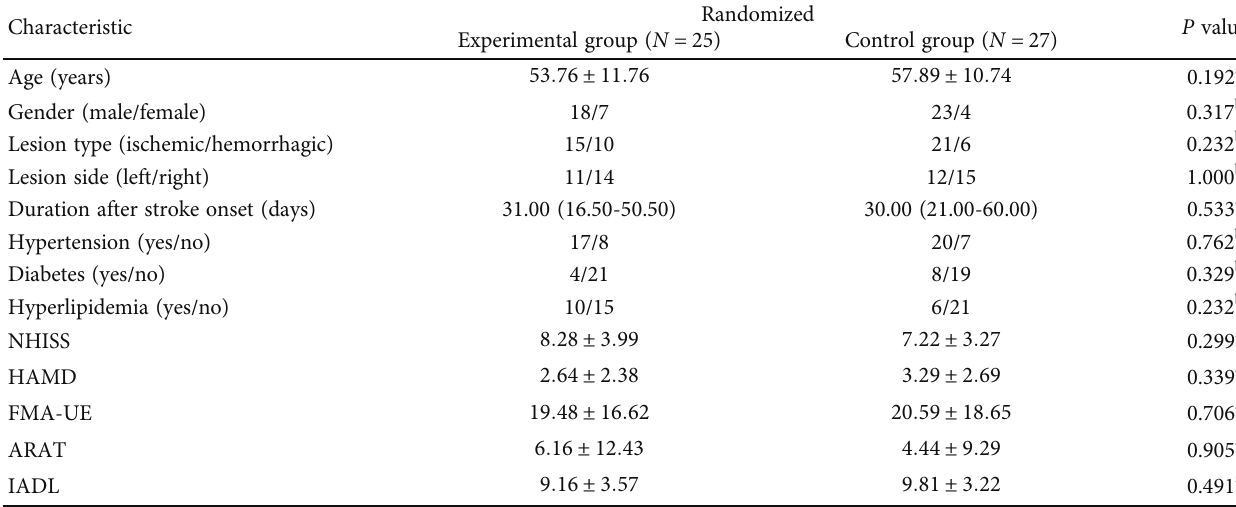
Table 1: Baseline characteristics of patients included in the study.